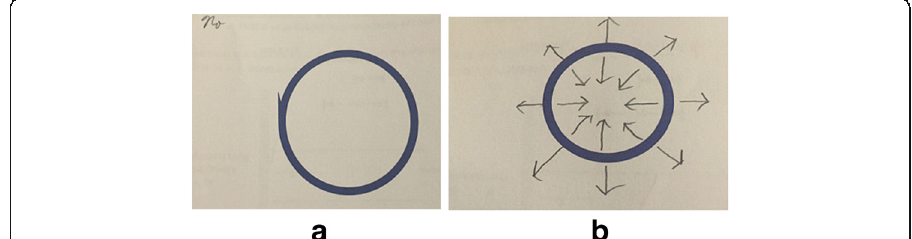
Fig. 8 Sample of a student's response from no understanding to a correct understanding. a Pre-test. b Post-test